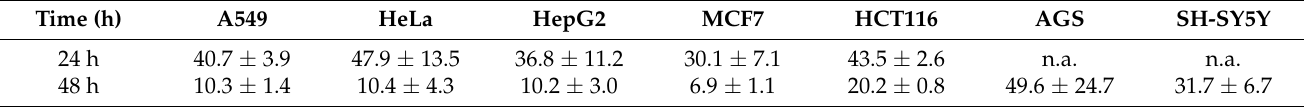
Table 1. IC 50 values ( µ M) of chlorophyllin on cancer cell